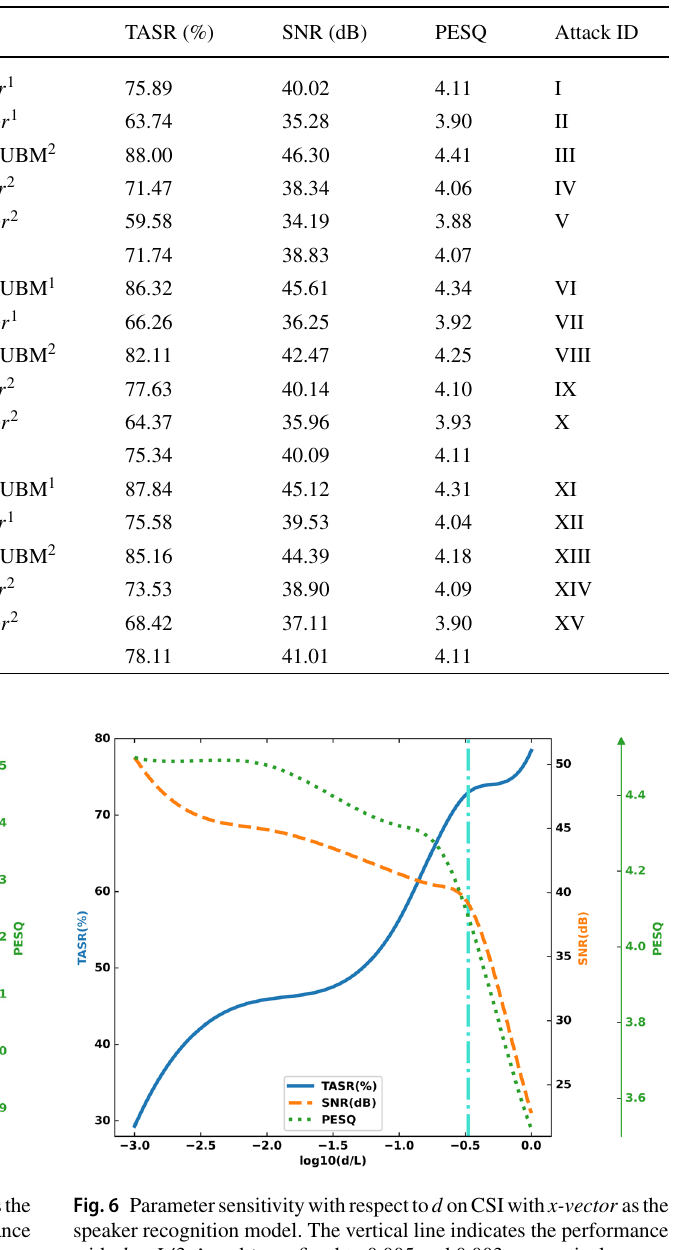
that λ (cid:2) 0.005, d (cid:2) L /3 and ζ (cid:2) 0.003 made a relatively